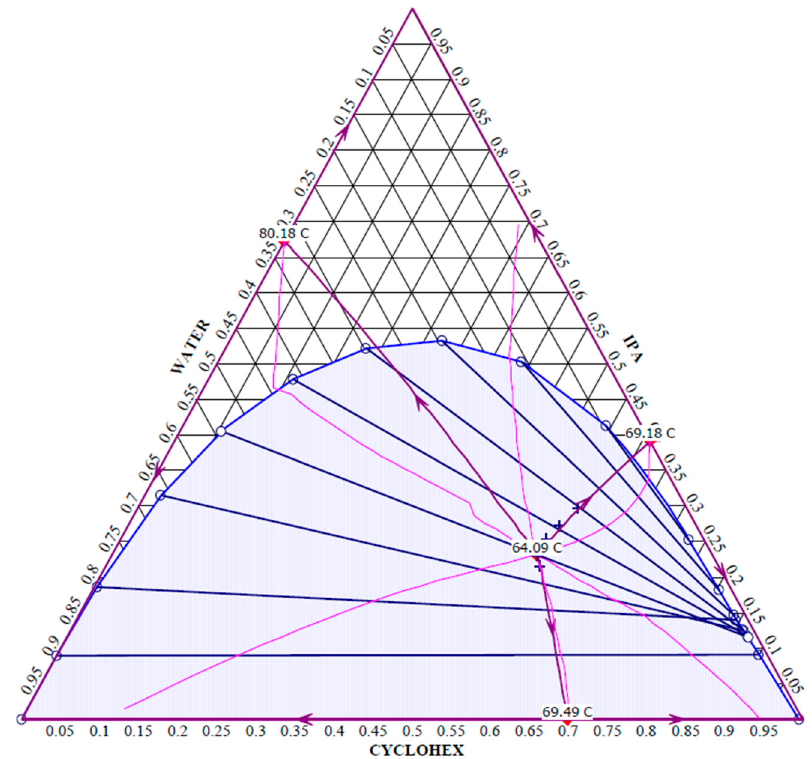
Figure 3. Ternary map at 1 atm, obtained by means of Aspen Plus ® V11 [61] using the NRTL model, for the system 2-propanol (IPA) + water (WATER) + cyclohexane (CYCLOHEX).